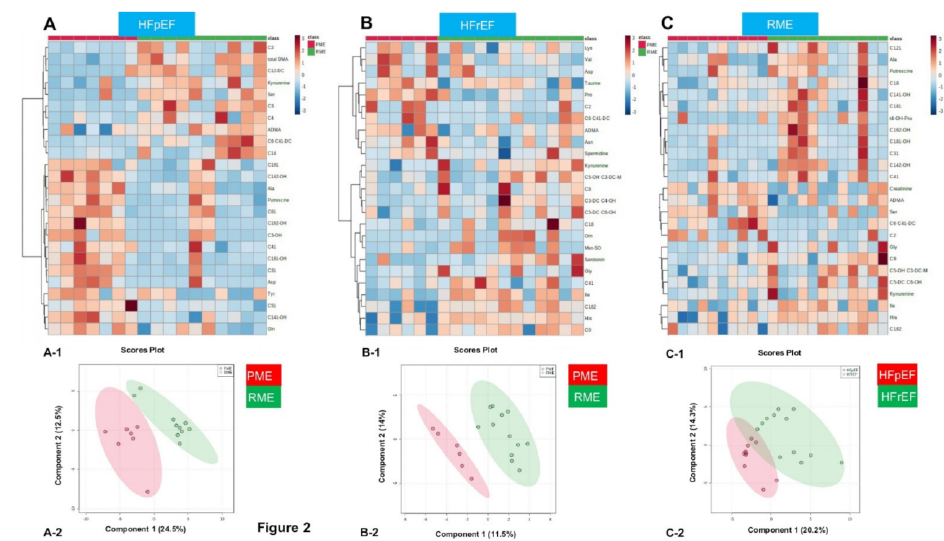
Figure 2. Metabolomic profiles of patients with reduced muscle endurance (RME) vs. preserved mus- cle endurance (PME) in HFpEF vs. HFrEF suggest different distorted metabolites and likely different mechanisms and metabolic pathways accompanying the RME. Visualization of the metabolomic profile using heat maps to show changes in the top 25 metabolite concentrations, and partial least squares-discriminant analysis (PLS-DA) among HFpEF (( A ), A-1 and A-2 ), HFrEF (( B ), B-1 and B-2 ), and in patients with RME and HFpEF vs. RME and HFrEF (( C ), C-1 and C-2 ), respectively.